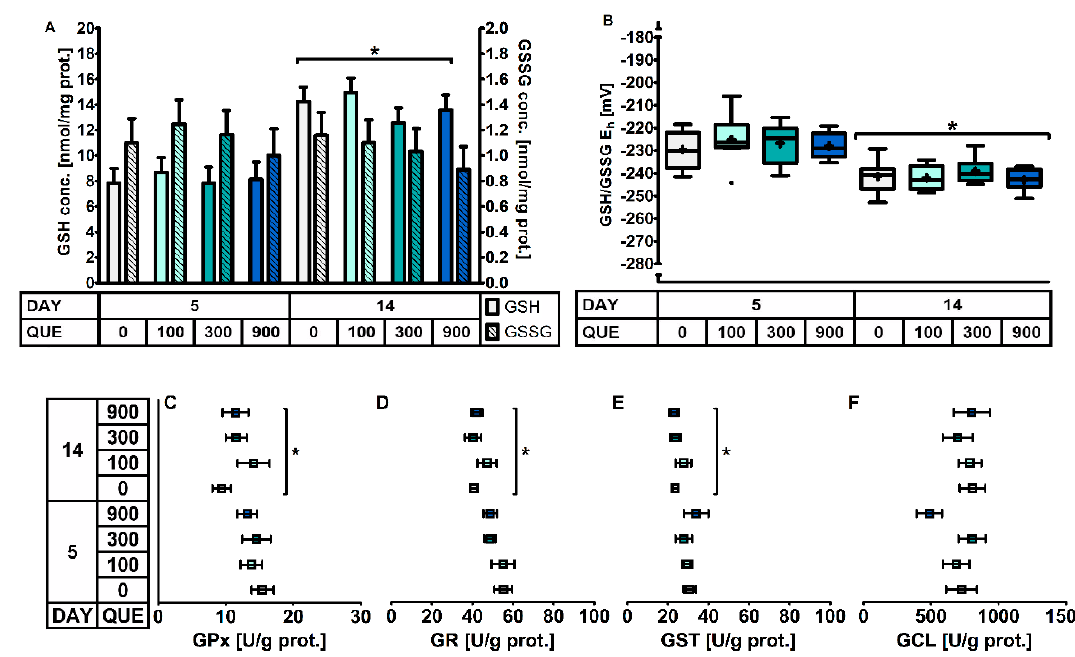
Figure 2. The glutathione redox system in the duodenal mucosa of piglets at d5 and d14 post-weaning (DAY), fed a diet containing 0, 100, 300, or 900 mg quercetin/kg diet (QUE) during the first 14d post-weaning. Results are presented as least squares means with SD. Significance levels of main effects and interaction terms are presented in Table 5: ( A ) glutathione (GSH) and glutathione disulphide (GSSG) concentrations; ( B ) Glutathione redox status (GSH/GSSG E h ); ( C ) Glutathione peroxidase (GPx)